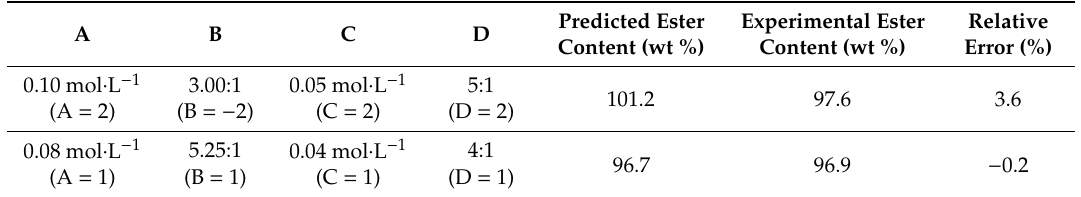
Table 3. Optimization of the